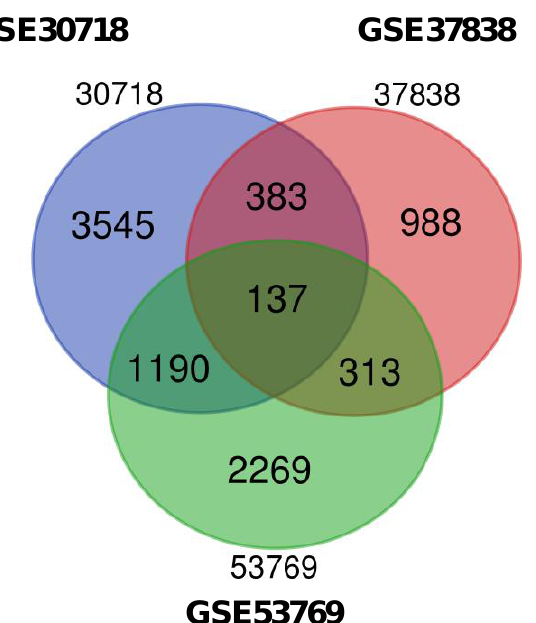
Figure 1. Venn diagram of DEGs common to all three GEO datasets. DEGs, differentially expressed genes; GEO, Gene Expression Omnibus.